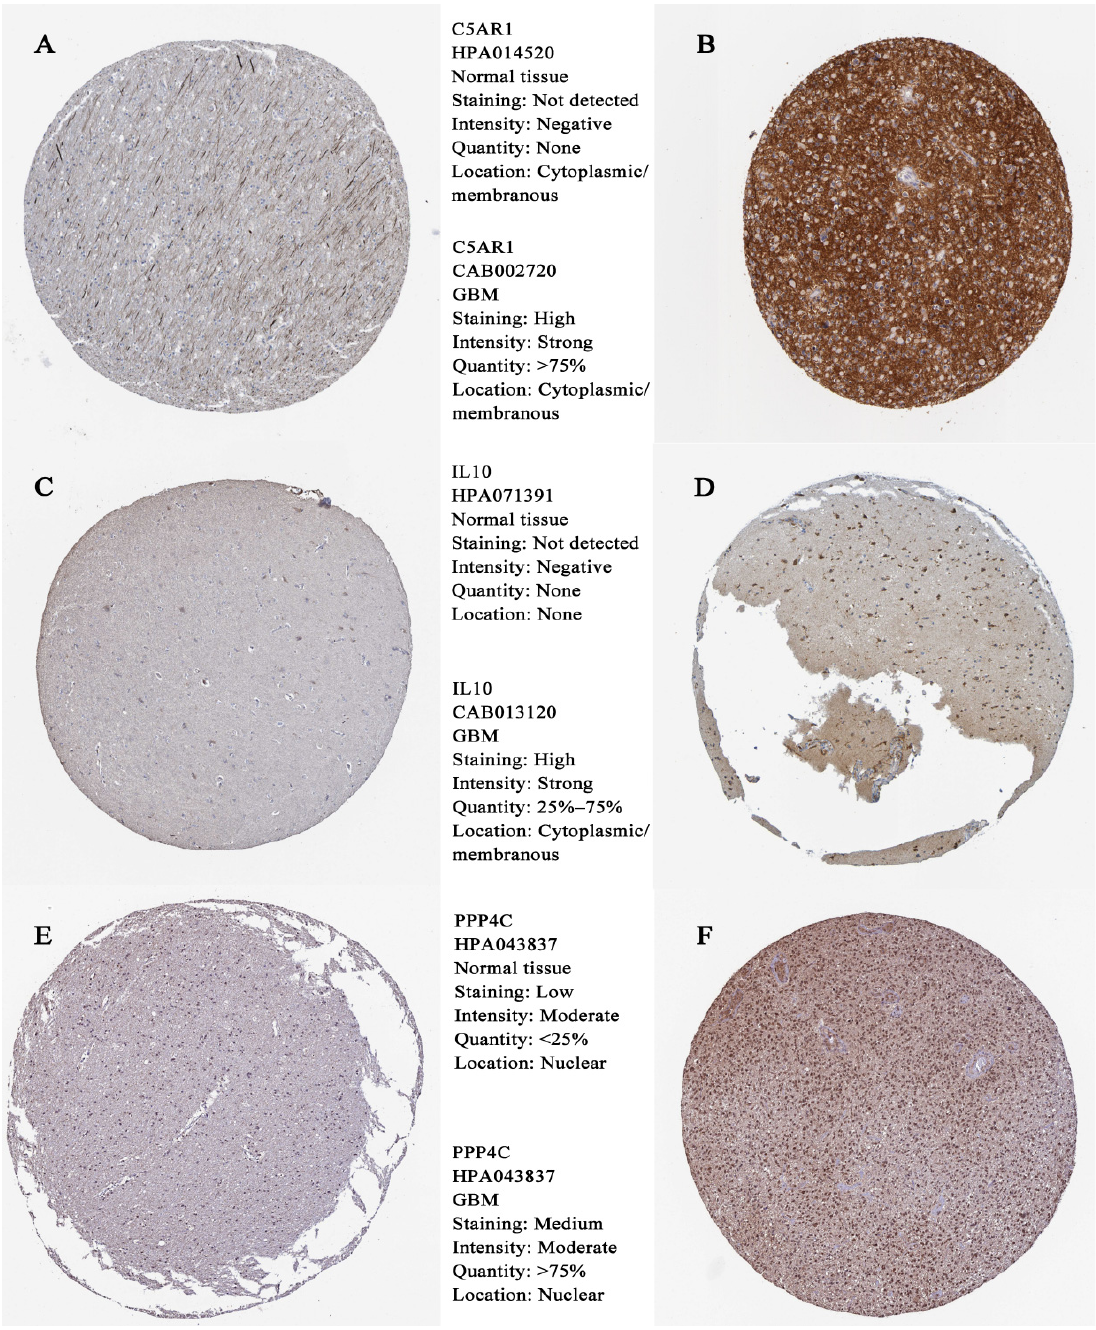
Figure 7. Hub gene expression in normal human and GBM tissue detected by immunochemistry. ( A ) Representative IHC staining of C5AR1 in normal human tissue; ( B ) IHC staining typical for C5AR1 in human GBM tissue; ( C ) IHC staining typical for IL10 in normal human tissue; ( D ) IHC staining typical for IL10 in human GBM tissue; ( E ) IHC staining typical for PPP4C in normal human tissue; ( F ) IHC staining typical for PPP4C in human GBM tissue.